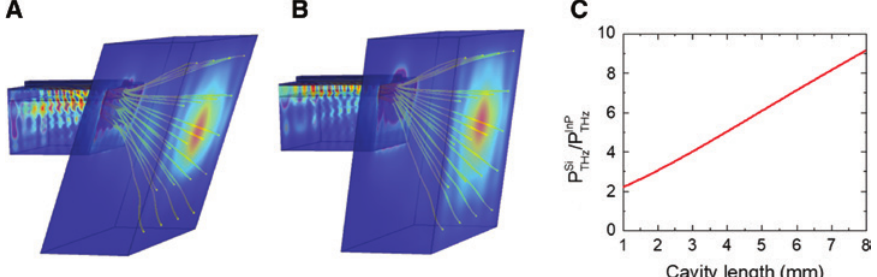
Figure 9: 3D Simulation results of Cherenkov THz DFG-QCLs. (A) Schematic of the Cherenkov THz DFG emission from a narrow-ridge THz DFG-QCL. (B) 3D COMSOL simulation of the THz power intensity outcoupled from the SI InP device to air. The yellow lines are the power streamlines indicating propagation direction of THz power outcoupled to equal points on the air monitor. All simulations assume uniform mid-IR pumps intensity in the laser cavity. Similar simulations are performed for the HR-FZ Si device. (C) The ratio of THz power of the HR-FZ-Si DFG-QCL to THz power of the SI InP reference device at different cavity lengths